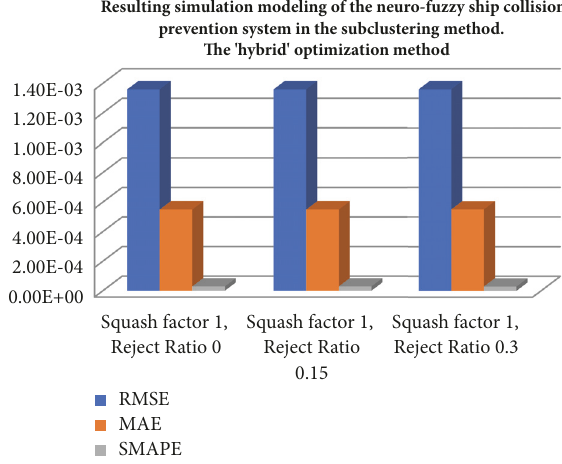
Figure 5: Resulting qualitative evaluation in the neural-fuzzy ship collision prevention system training in the generation of the hybrid algorithm through the subclustering